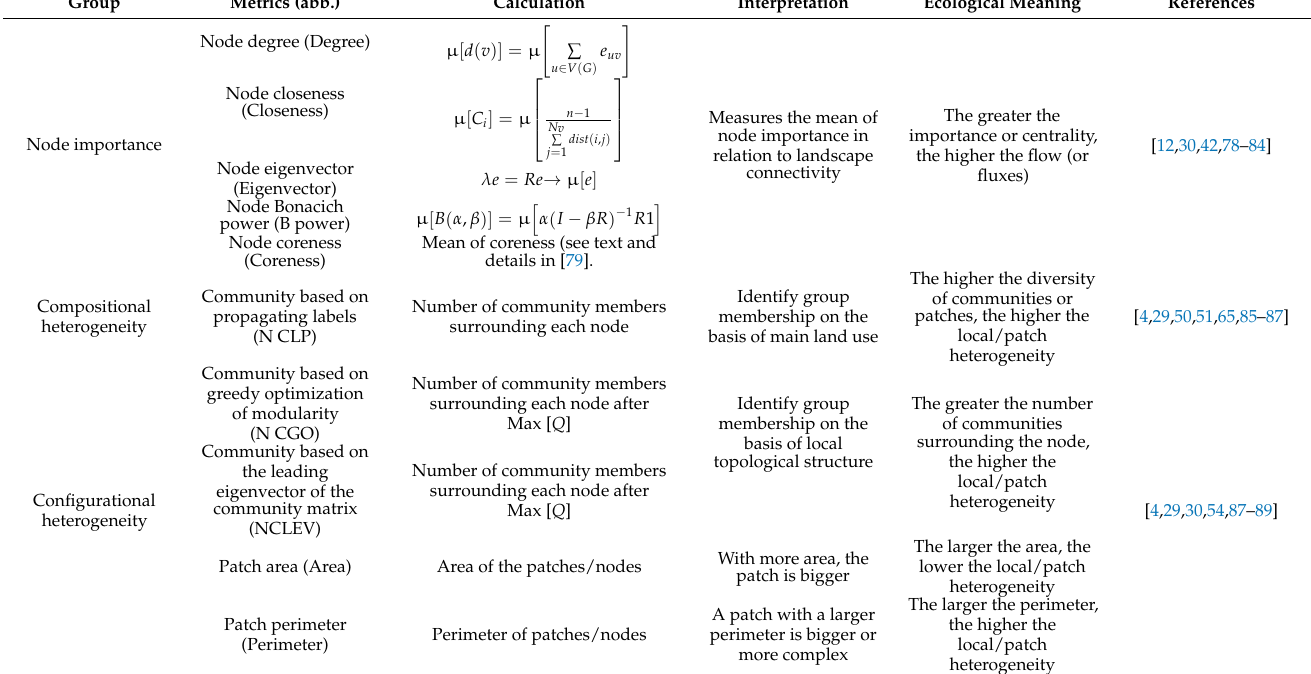
Table 2. Graph metrics describing landscape at the local scale, considering node importance and compositional and configurational